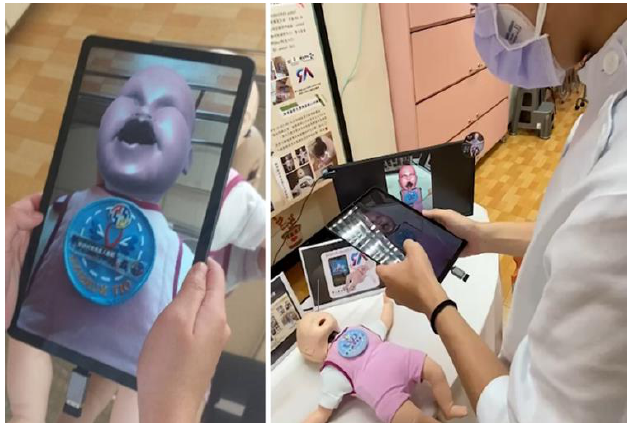
Figure 1. AR scanning system.